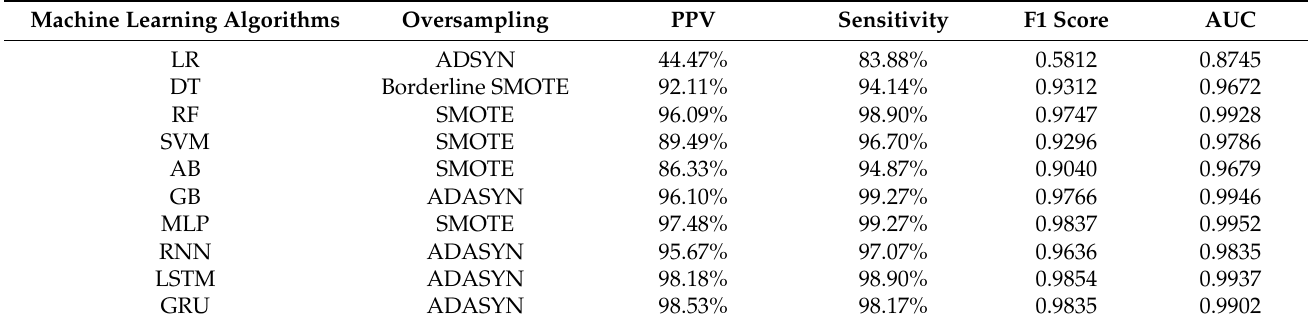
Table 10. Highest prediction performance of each machine learning